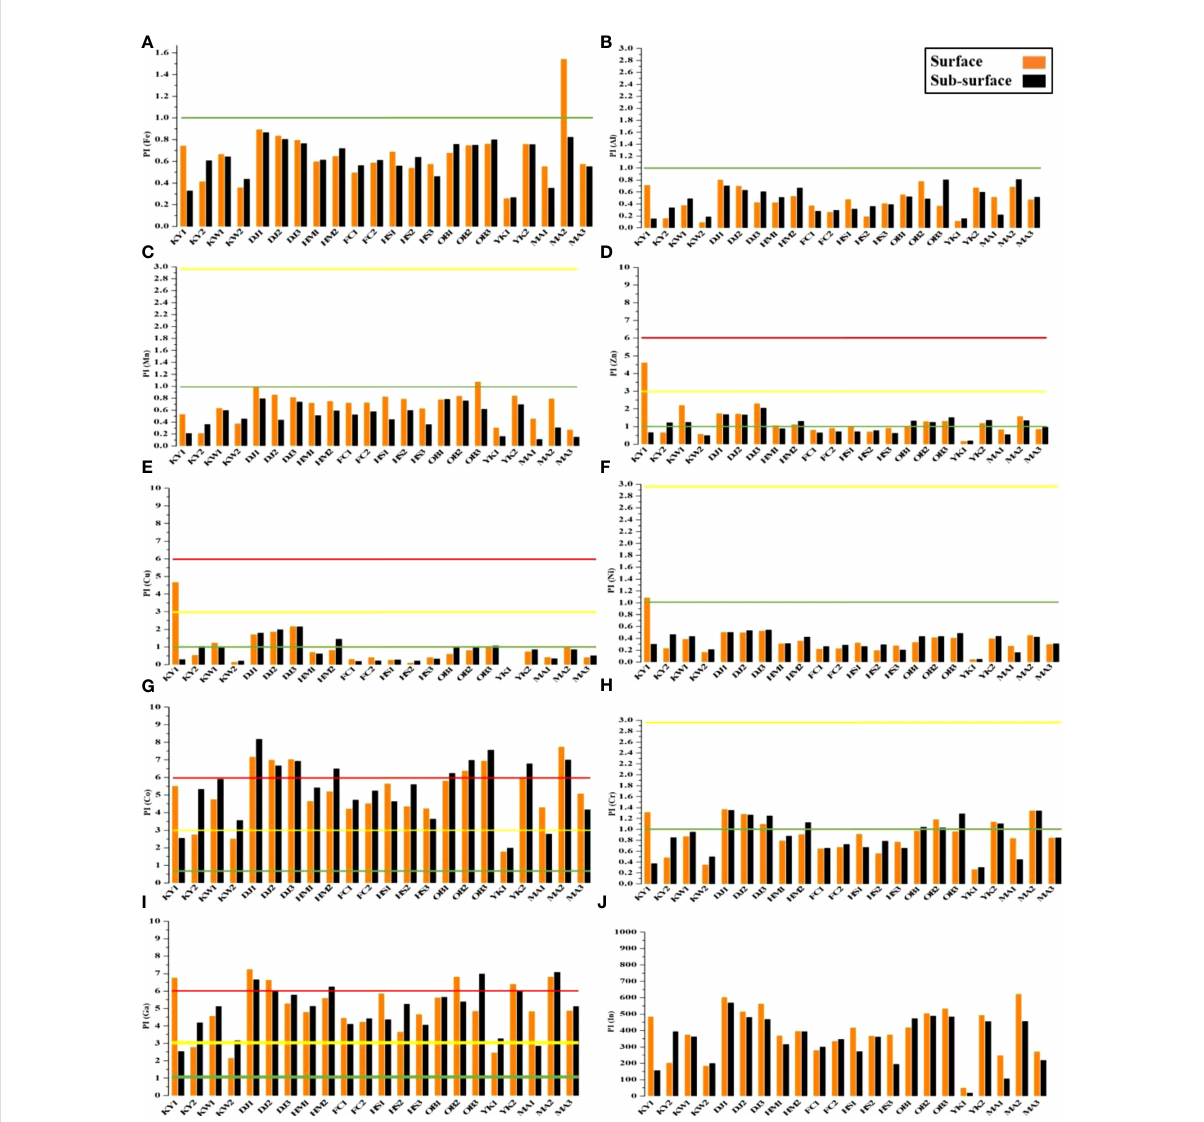
FIGURE 6 Pollution index (PI) with pollution degree for studied metals in surface and sub-surface sediments of Siangshan wetland. Green, yellow, and red lines refer to classes 0, 1, and 2, respectively (Table